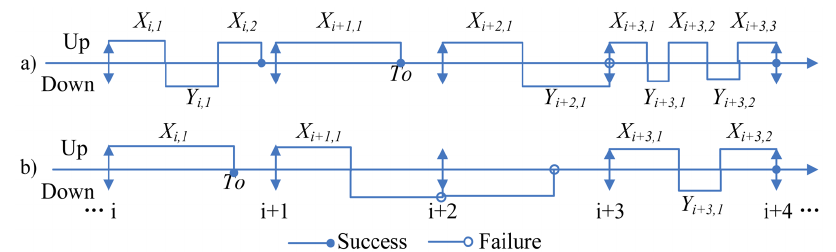
Figure 1. Execution process of system missions.